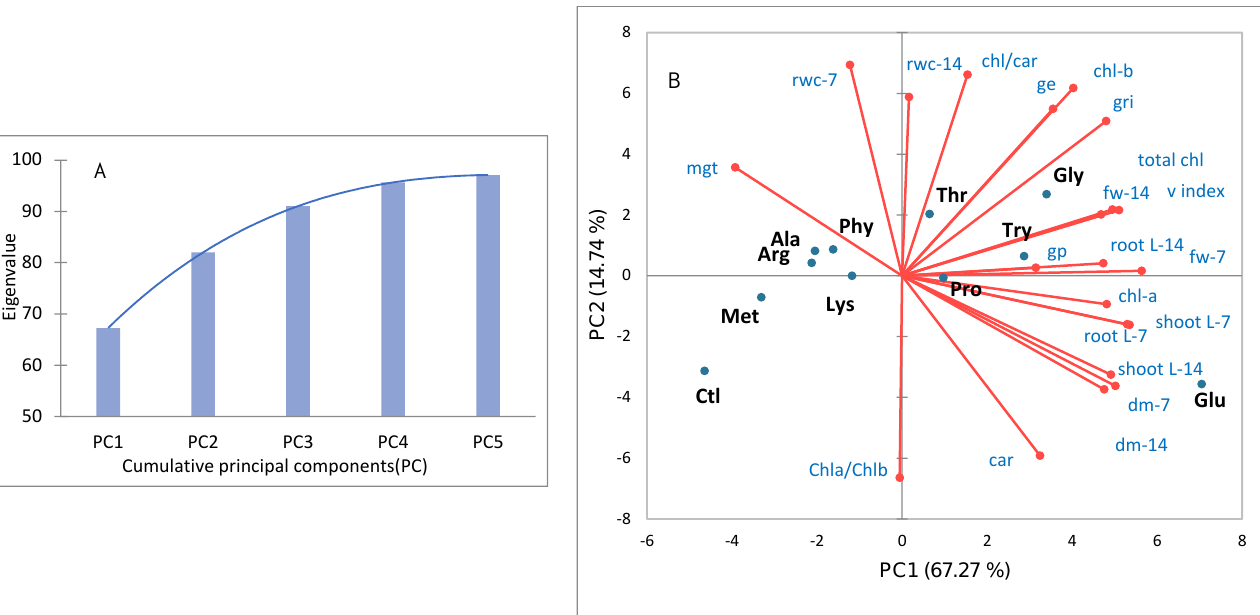
Figure 8. ( A ) Principal component analysis, PC1 and PC2 explained 82.01% of the total variation. ( B ) PCA components variability of growth, development, and pigment contents of onion seedlings primed with amino acids. Ctl (Control); Ala (Alanine); Arg (Arginine); Glu (Glutamine); Gly (Gly-cine); Lys (Lysine); Met (Methionine); Phy (Phenylalanine); Pro (Proline); Thr (threonine); Try (try-tophan).